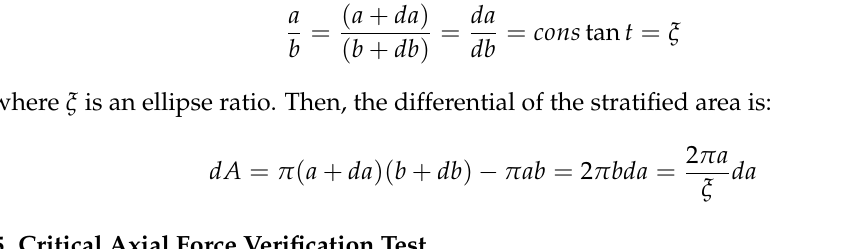
Figure 12. Change curve of thermal expansion coefficient of one-way plate with temperature.